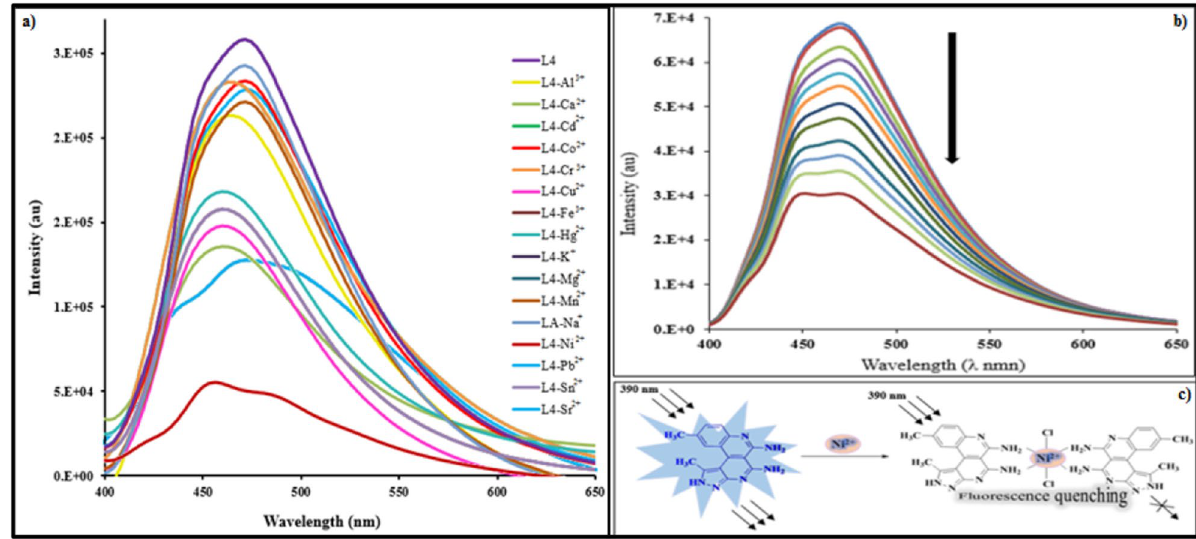
Figure 3. ( a ) Fluorescence spectral changes of L4 (20 µM) in the presence of different metal ions in DMSO– H 2 O (v/v 1:2, HEPES buffer pH = 7.4), (λ ex = 390 nm), ( b ) Fluorescence spectra of receptor L4 (20 µM) in the presence of various concentrations of Ni 2+ (0–12 µM) HEPES buffer, pH = 7.4 (λex = 390 nm), ( c ) Proposed detection mechanism of receptor L4 to Ni 2+